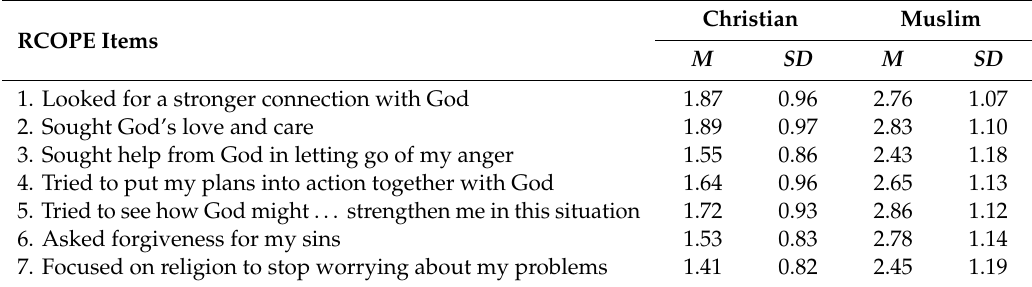
Table 5. Means standard deviations and t-test e ff ect sizes for RCOPE items by faith grouping. RCOPE